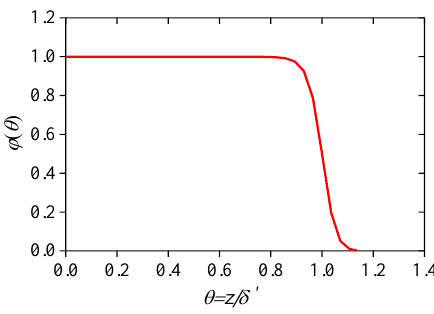
Figure 4. The damping factor ϕ ( θ ) .